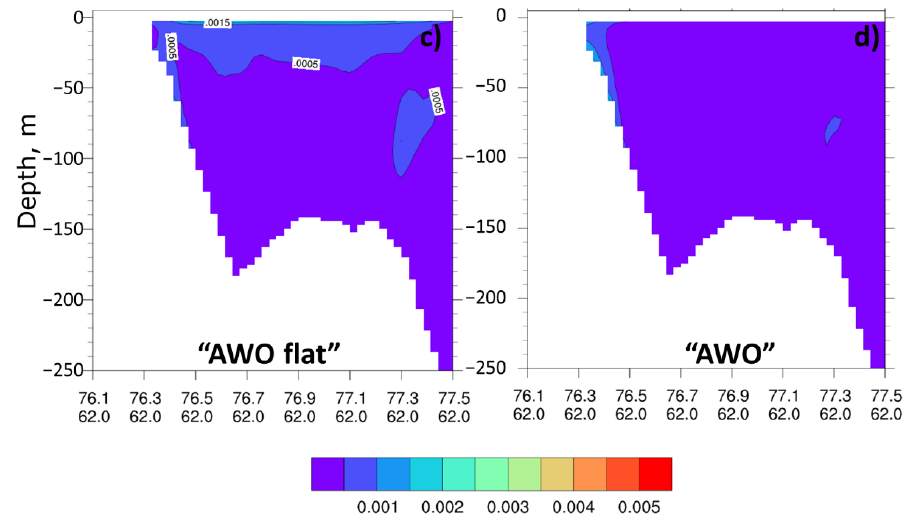
Figure 12. Cross-section of TKE (m 2 s −2 ) along 72.3° N ( a , b ) and 62° E ( c , d ) in “AWO flat” ( a , c ) and “AWO” ( b , d ) experiments.